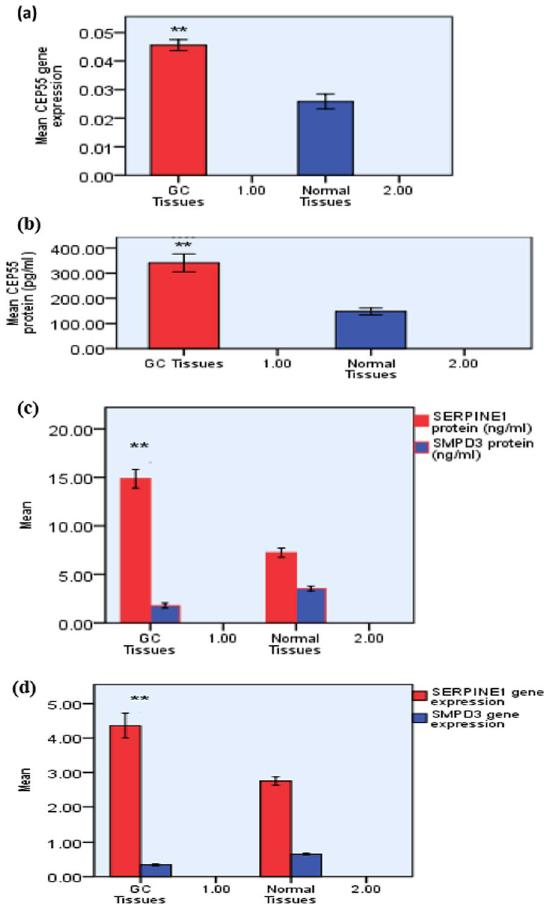
Fig. 1 SERPINE1, CEP55, and SMPD3 genes and proteins expressions in the studied gastric tissues. a CEP55 gene in the studied gastric tissues. b CEP55 protein in the studied gastric tissues. c SERPINE1 and SMPD3 proteins in the studied gastric tissues d SERPINE1 and SMPD3 genes in the studied gastric tissues **; high significant differences (p < 0.001) in gastric cancer tissues than normal